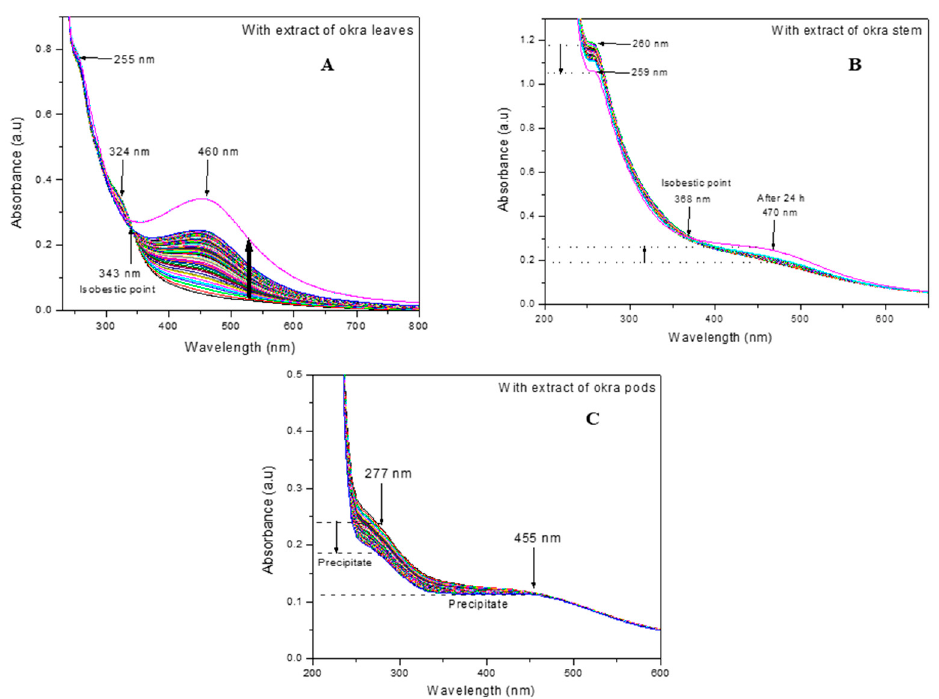
Figure 2. UV-Vis absorption spectrum of silver nanoparticles: ( A ) synthesized using aqueous extract of okra leaves; ( B ) using aqueous extract of okra stem; ( C ) using aqueous extract of the okra pods.